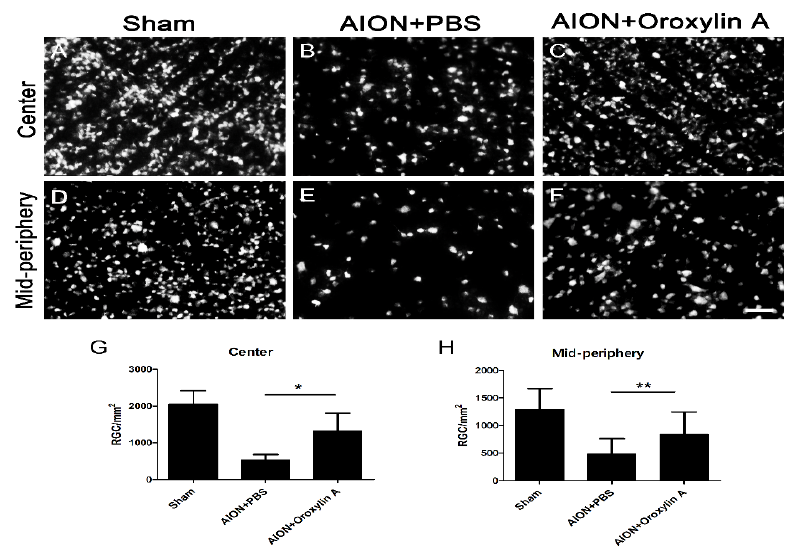
Figure 2. Effect of OA on the preservation of retinal ganglion cells (RGCs) after rAION. Representative images of RGC density in the retinal whole mount after rAION in each group ( A – F ). The RGC density of the OA-treated group was markedly higher than that of the PBS-treated group in the ( G ) central (1315 ± 490 versus 538 ± 144 cells/mm 2 , respectively) and ( H ) mid-peripheral retina (847 ± 400 versus 487 ± 274 cells/mm 2 , respectively). Results represent the means ± SDs. Scale bar, 50 μ m; * p ≤ 0.05, ** p ≤ 0.01; n = 6.